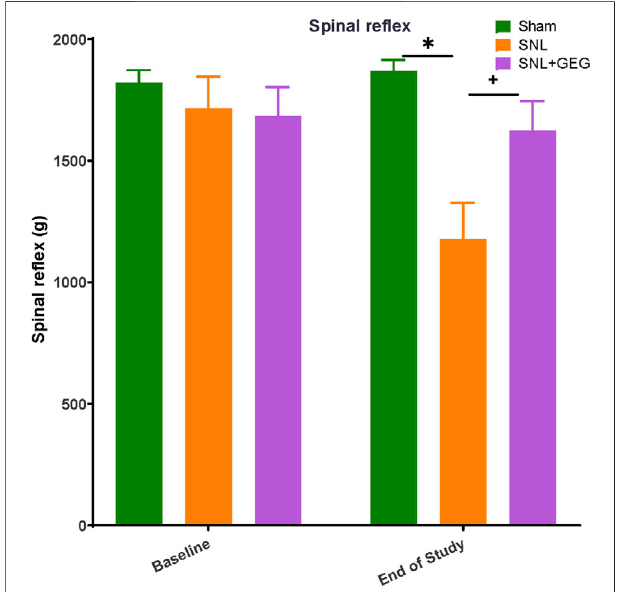
FIGURE 2 | GEG increased the mechanical thresholds of SNL rats as assessed by compression of the hind paw with calibrated forceps. Data is expressedasmean±SEM. n =5 – 6pergroup.Datawasanalyzedbyone-way ANOVA followed by a post hoc Tukey ’ s test at each collection time. * p < 0.05 vs Sham. + p < 0.05 vs